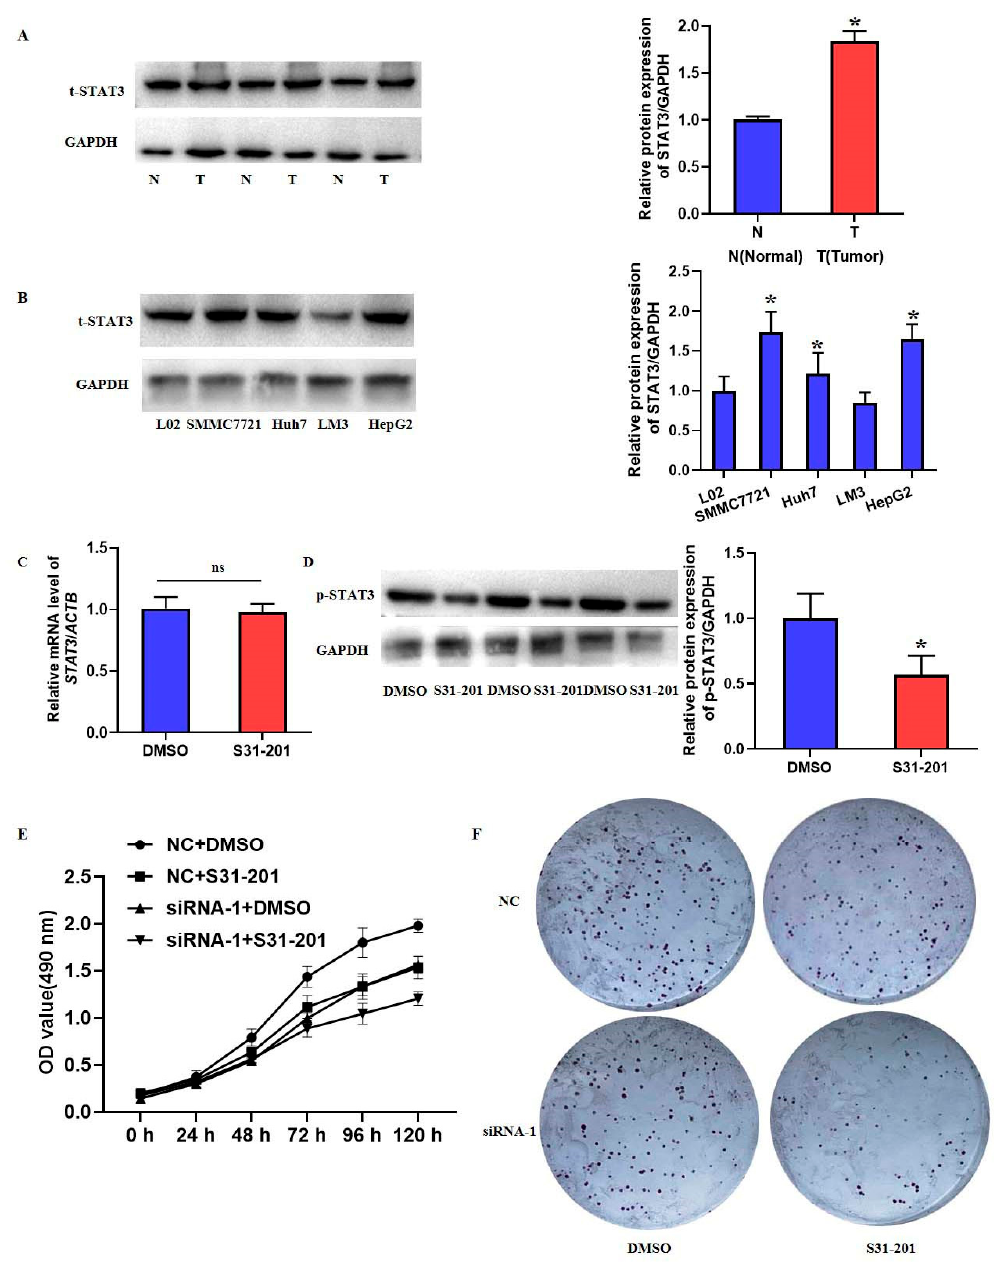
Figure 11. Role of phosphorylated STAT3 in the proliferation of HCC cells. ( A ) The protein expression of STAT3 in HCC and normal tissues. ( B ) The protein expression of STAT3 in L02 hepatocytes and HCC cell lines. ( C ) S31-201 (inhibitor of p-STAT3) was used to treat SMMC7721 cells. The mRNA level of STAT3 was detected by qRT-PCR. ( D ) Western blot was performed to assay the phosphorylation of STAT3. The proliferation of SMMC7721 cell lines were examined by ( E ) MTT assay and ( F ) colony formation assay. Image J software was used to analyze the relative levels of proteins normalized to the expression of GAPDH. * p < 0.05, compared with its relative control.